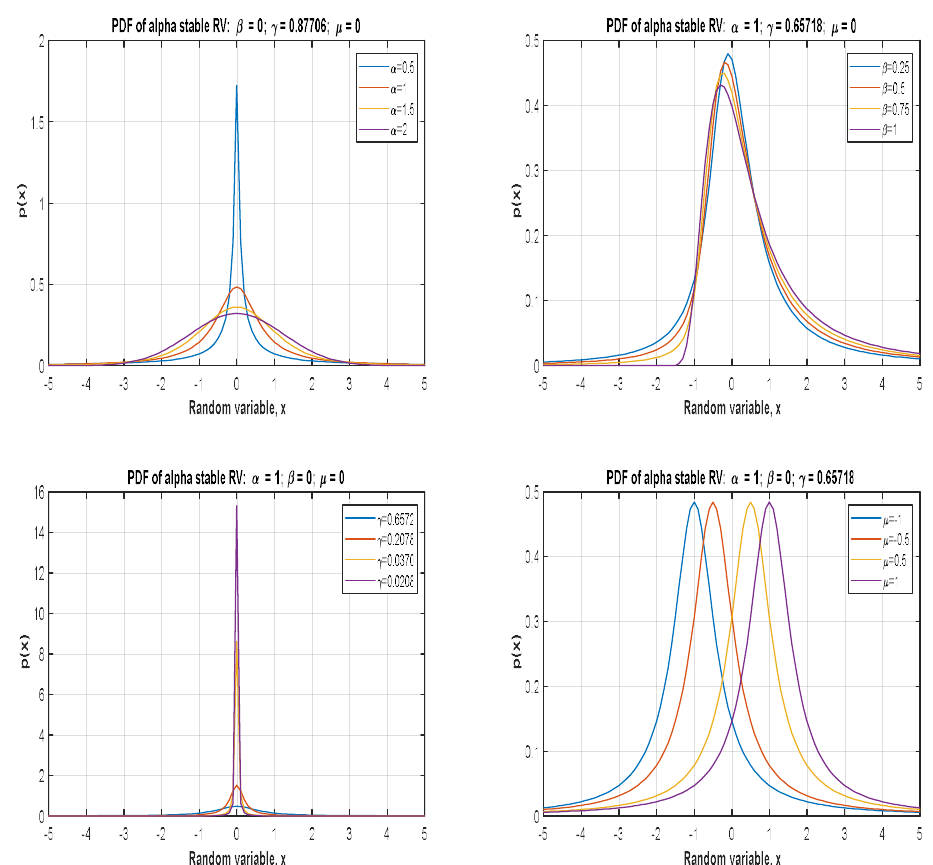
Figure 11. α -Stable probability density functions with different Figure 11. α-Stable probability density functions with different parameters.